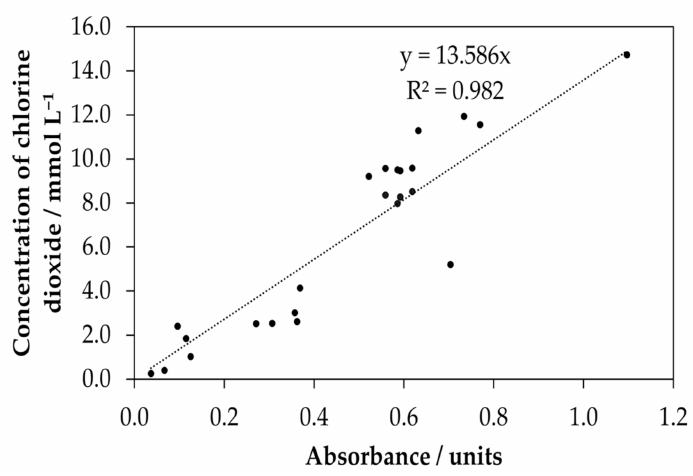
Figure 4. Relationship between the maximum reached in the absorbance at 360 nm and the amount of limiting reagent reacted in the interaction between hydrogen peroxide and